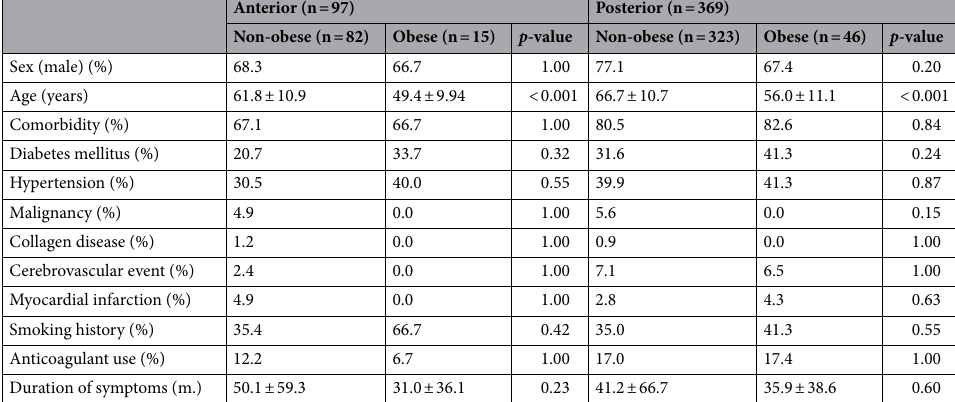
Table 4. Patients’ demographic data stratified by approach. Age and duration of symptoms were represented by mean ± standard deviation. Non-obese: BMI < 30.0 kg/m 2 ; Obese: BMI ≥ 30.0 kg/m 2 ; BMI: body mass index.